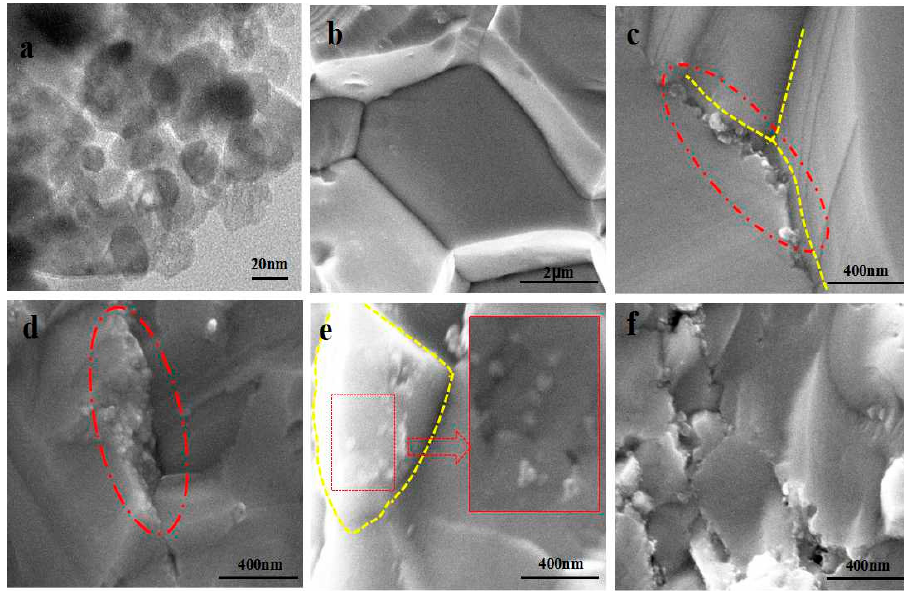
Figure 5. ( a ) TEM image of the initial TiO 2 nanoparticles. ( b – f ) SEM images of the x vol % TiO 2 /Cu 2 SnSe 3 composites: ( b ) x = 0; ( c ) x = 0.6; ( d ) x = 1.0; ( e ) x = 1.4; ( f ) x = 1.8. Table 1. Density of the x vol % TiO 2 /Cu 2 SnSe 3 composites with different nano-TiO 2 content. x TiO 2 /Cu 2 SnSe 3